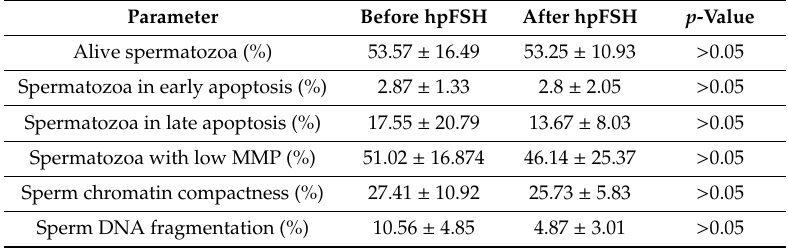
Table 3. Bio-functional sperm parameters before and after hpFSH treatment in responder patients.